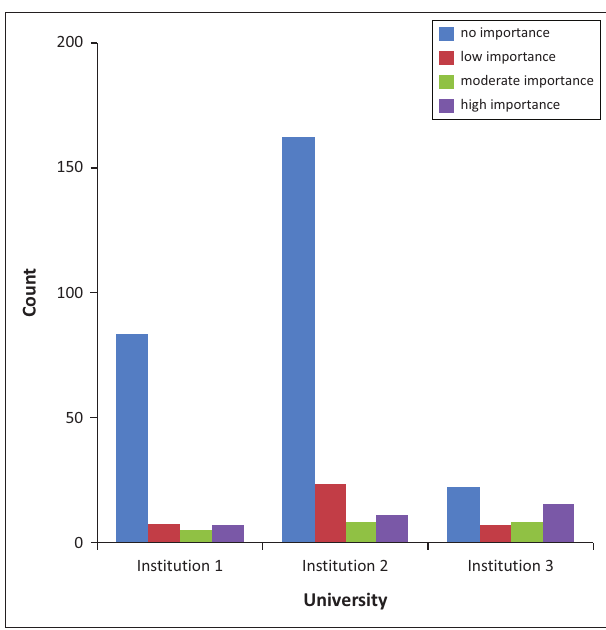
FIGURE 1: Graph illustrating response to ‘I received funding ...’ by institution.